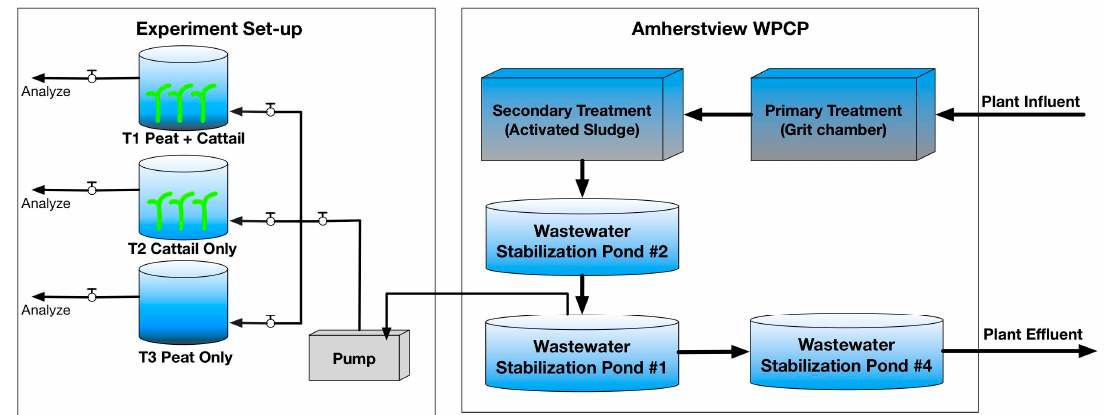
Figure 1. Schematic design of the experiment set-up and the treatment processes flow at the Amherstview Water Pollution Control Plant (WPCP).